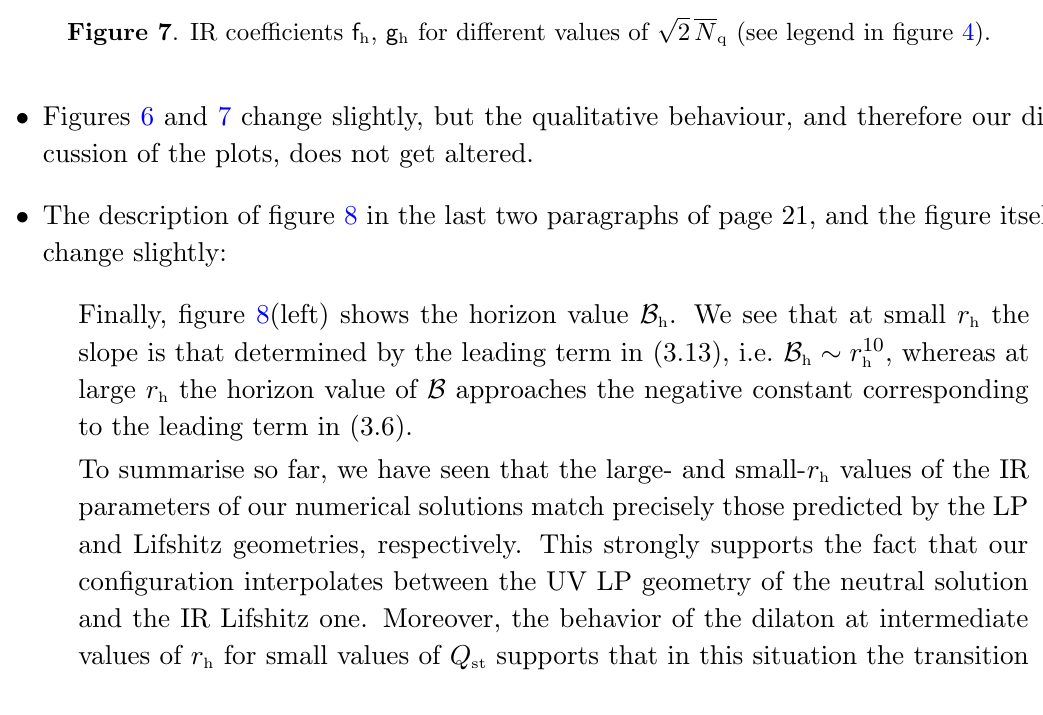
Figure 7 . IR coefficients f